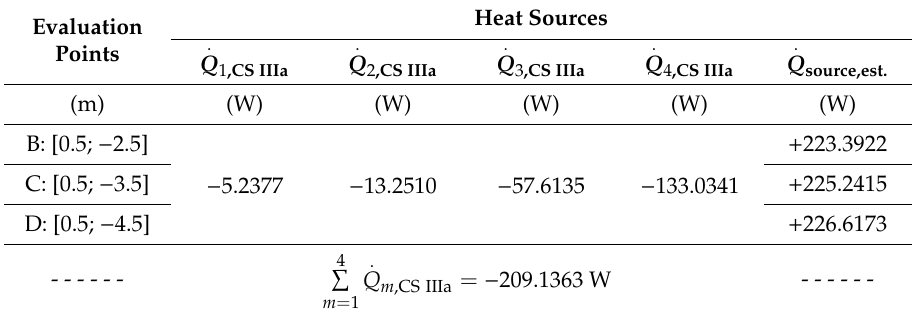
. Q 2,CS IIIa and . . Q 1,CS IIIa and Q 4,CS IIIa for evaluation points B, C, 𝑄(cid:4662) 𝑄(cid:4662) (cid:2869),(cid:2887)(cid:2903) (cid:2893)(cid:2893)(cid:2893)(cid:2911) and (cid:2872),(cid:2887)(cid:2903) (cid:2893)(cid:2893)(cid:2893)(cid:2911) for evaluation points B, C,